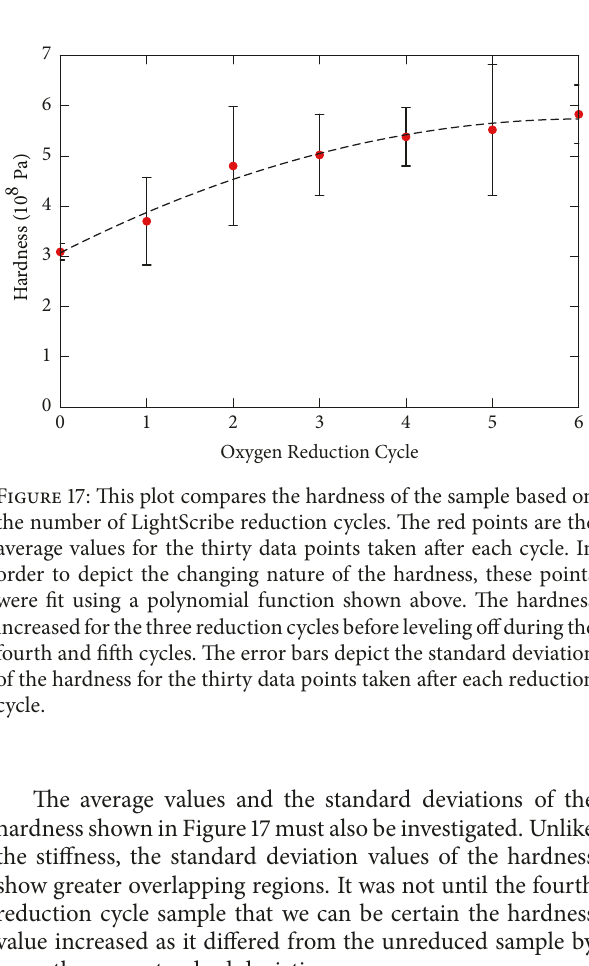
Figure 16: This plot compares the stiffness of the sample based on the number of LightScribe reduction cycles. The red points are the average values for the thirty data points taken after each cycle. In ordertodepictthe changingnatureof the stiffness,thesepointswere fit using a polynomial function shown above. The error bars depict thestandard deviation of the stiffnessfor thethirty data points taken after each reduction cycle.